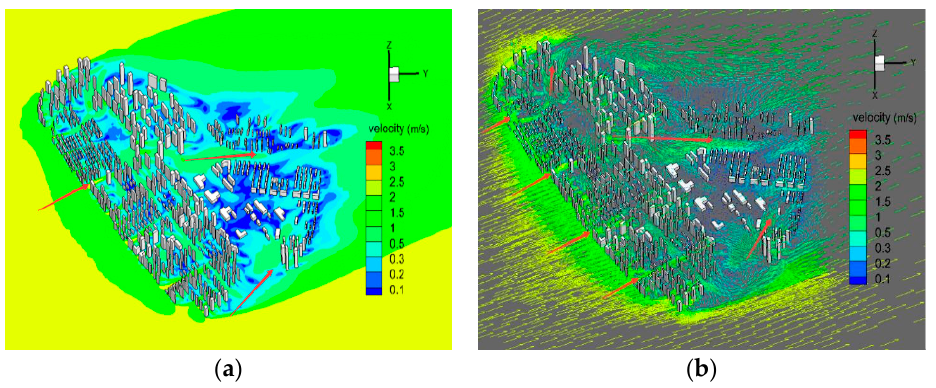
Figure 6. Urban wind velocity distribution in summer: ( a ) Contour plot; ( b ) Vector plot.